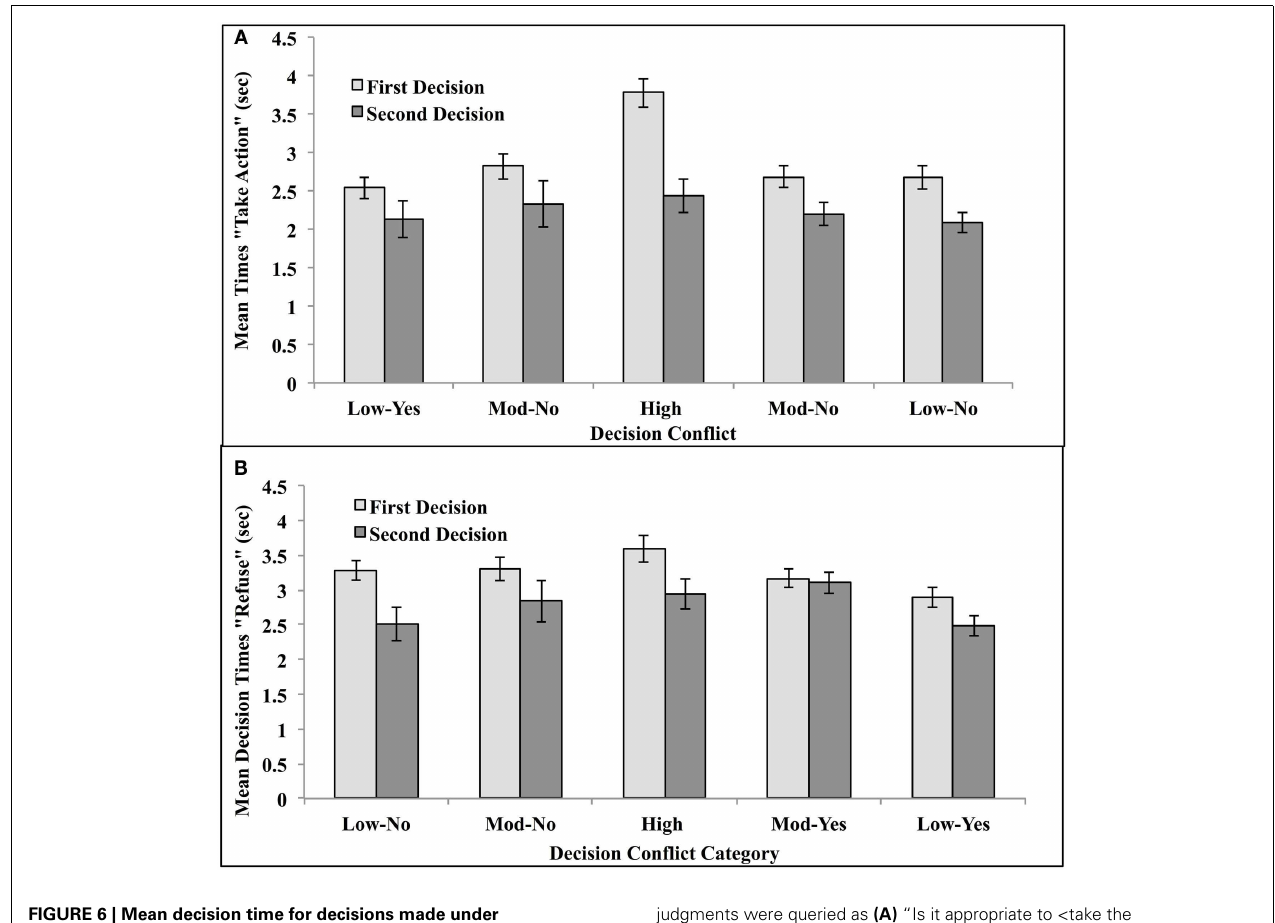
FIGURE 6 | Mean decision time for decisions made under unlimited- and reduced-decision time for high-conflict vignettes, moderate conflict vignettes, and low-conflict vignettes in Experiment 2. First decisions were made within a time constraint of 6s. Second decisions were made without time constraints.